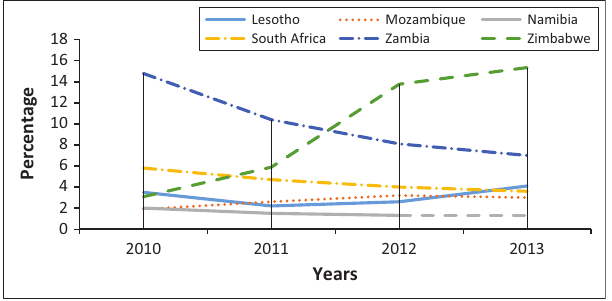
FIGURE 2: Regional comparison of non-performing